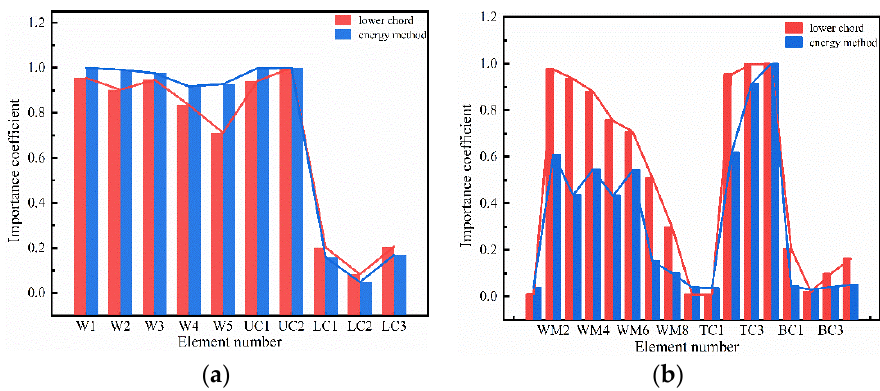
Figure 15. Relative importance coefficient: ( a ) Test truss, ( b ) steel roof truss.